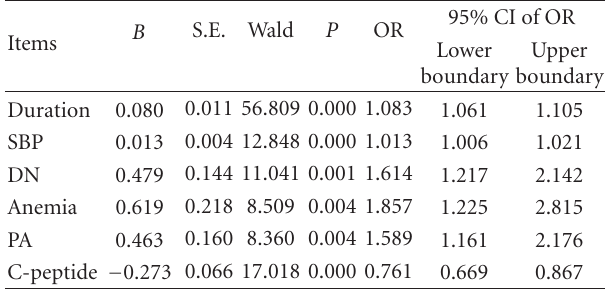
Table 3: Logistic-regression-identified factors associated with DR.